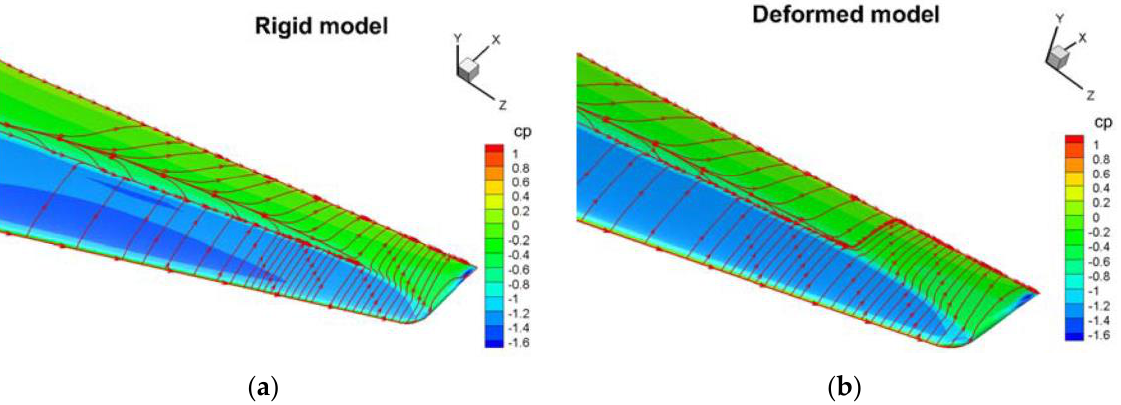
Figure 8. Numerical flow patterns near the wing tip with and without deformation (M = 0.76, Re = 15 × 10 6 , Q = 94 kPa, α = 4°): ( a ) rigid model; ( b ) deformed model.